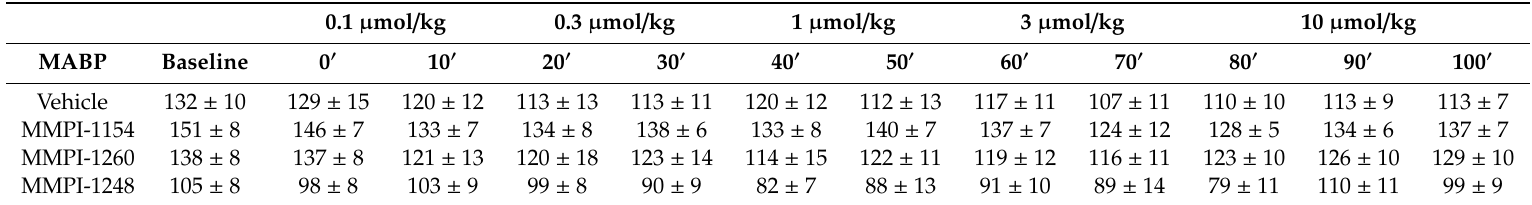
Table 1. Mean arterial blood pressure (mmHg) of the animals during tolerability testing.